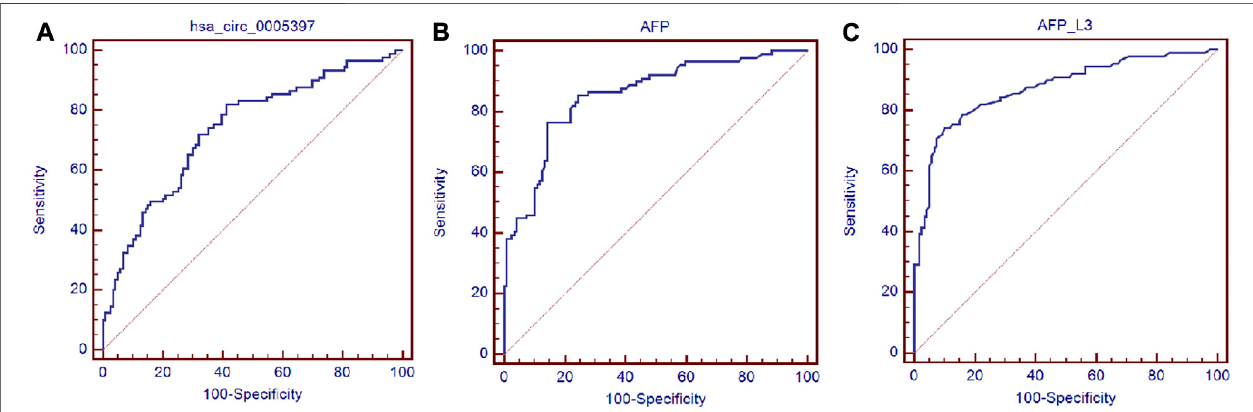
FIGURE 5 | Diagnosis utility of plasma hsa_circ_0005397 for HCC. (A – C) Construction of ROC curve to compare the diagnostic performance of plasma hsa_circ_0005397, serum AFP and AFP-L3 to discriminate HCC from benign liver diseases and healthy controls.